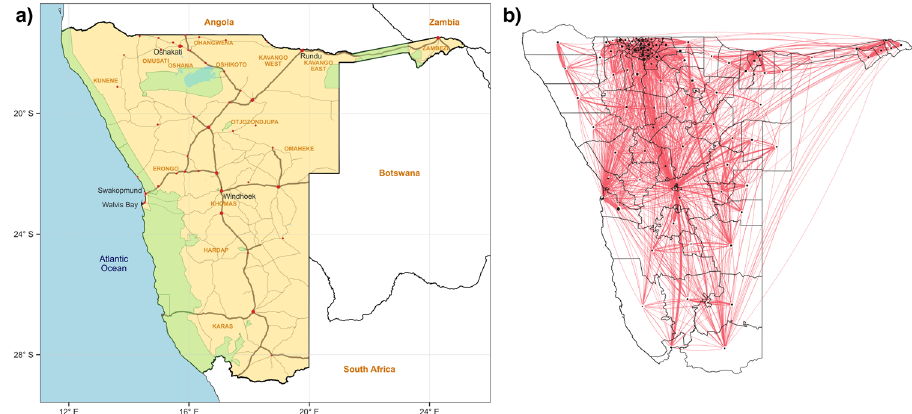
Fig. 1 Geography of Namibia and mobility network. a Map of Namibia. Red dots indicate main cities and towns. The names of the fi ve largest cities appear in black. Region names appear capitalized in orange. Names of bordering countries appear in orange in bold. National park areas are indicated in green, water bodies in light blue. National borders appear in black. Main road (thick) and secondary roads (thin) are indicated in brown. b Map of mobility network, constructed from CDRs, based on an OD matrix constructed by Ruktanonchai and colleagues 34 . Red lines show travel between